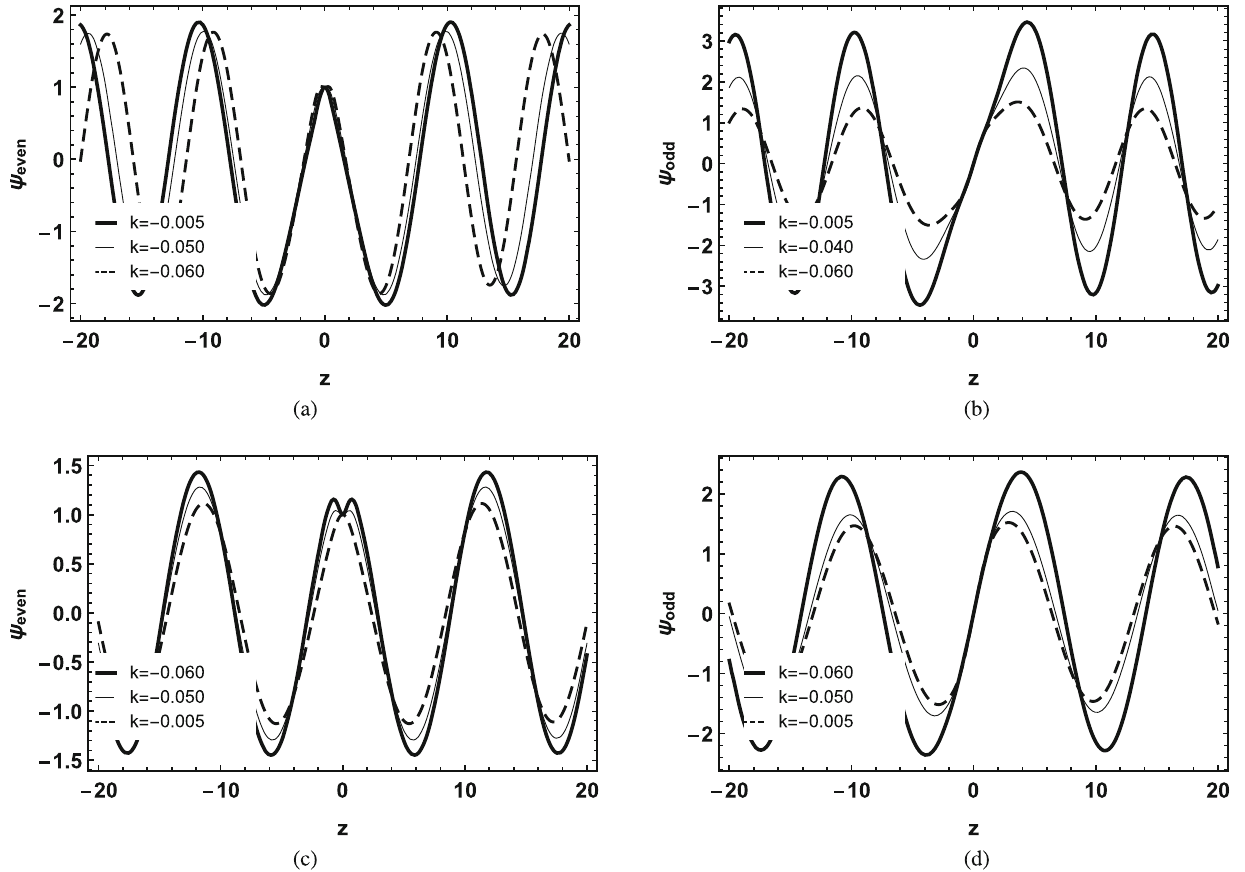
Fig. 16 The behavior of massive modes for G 1 ( T ) , with n = 2 and p = λ = 1. To the Gauge field, a ψ e v en with m = 0 . 651. b ψ odd with m = 0 . 661. KR field, c ψ e v en with m = 0 . 476. d ψ odd with m = 0 .